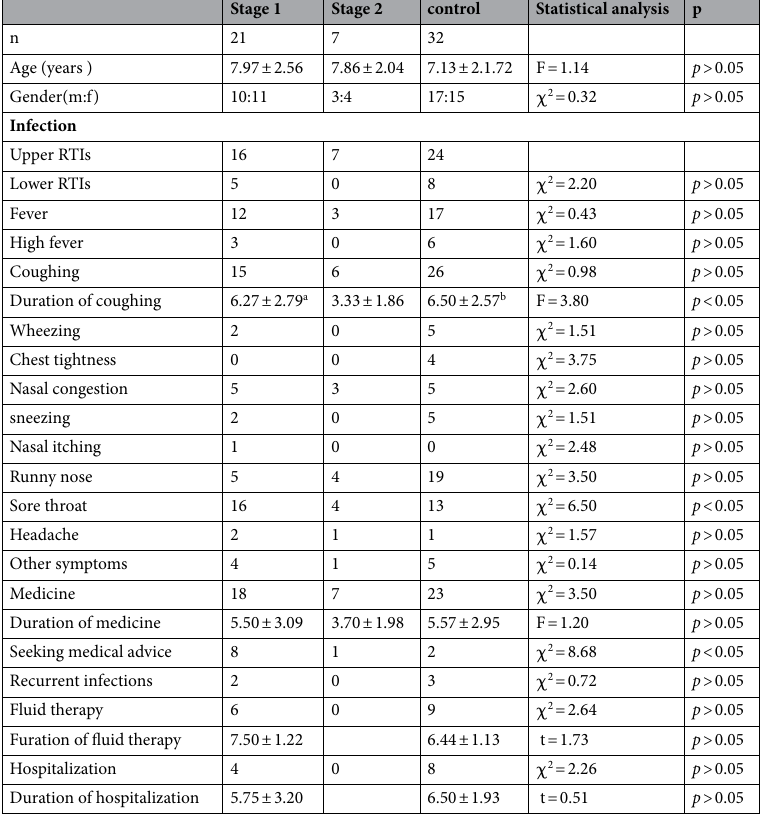
Table2. Clinical characteristics of children with RTIs. a Comparison between stage1 and stage2, p < 0.05; b Comparison between stage2 and control, p <